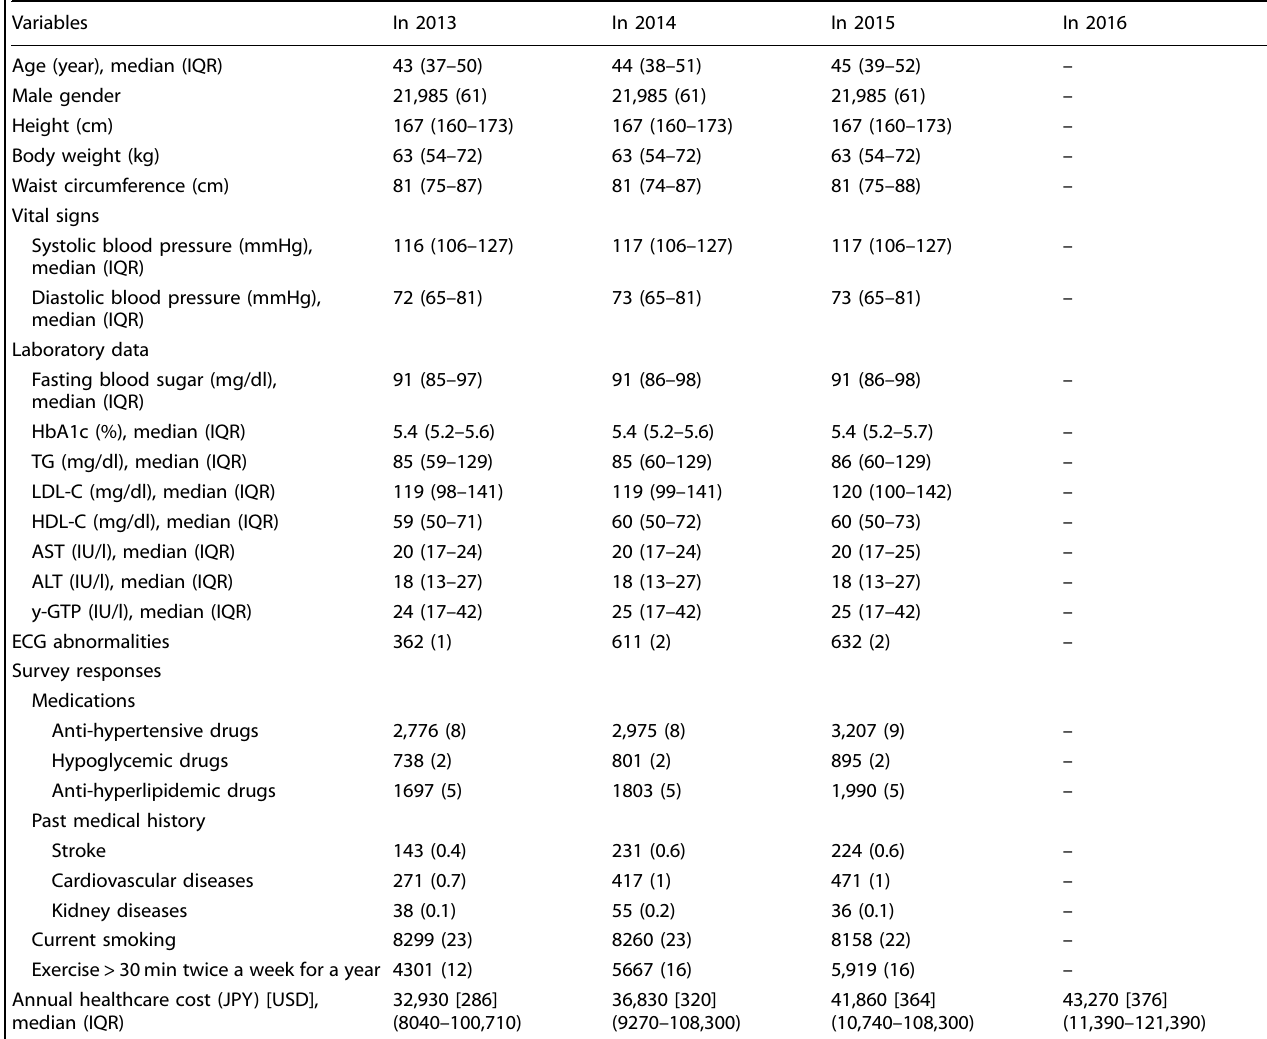
Table 1. Predictor variables and outcome in 36,316